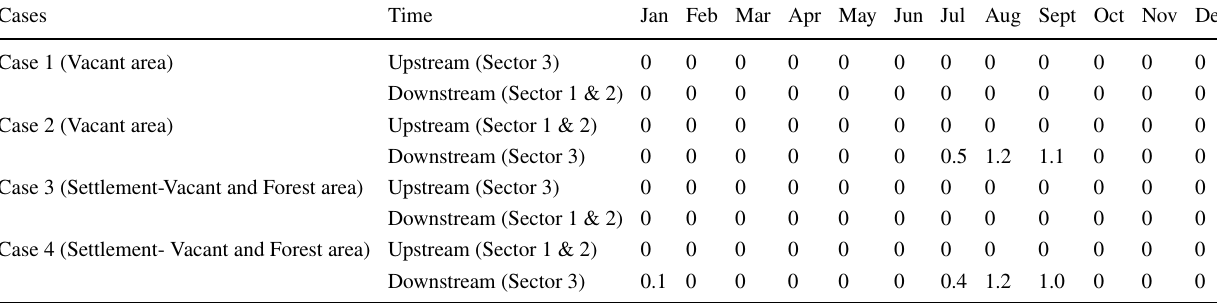
Table 2 The results of the spatially-resolved coupled model for water scarcity (dam 3 )